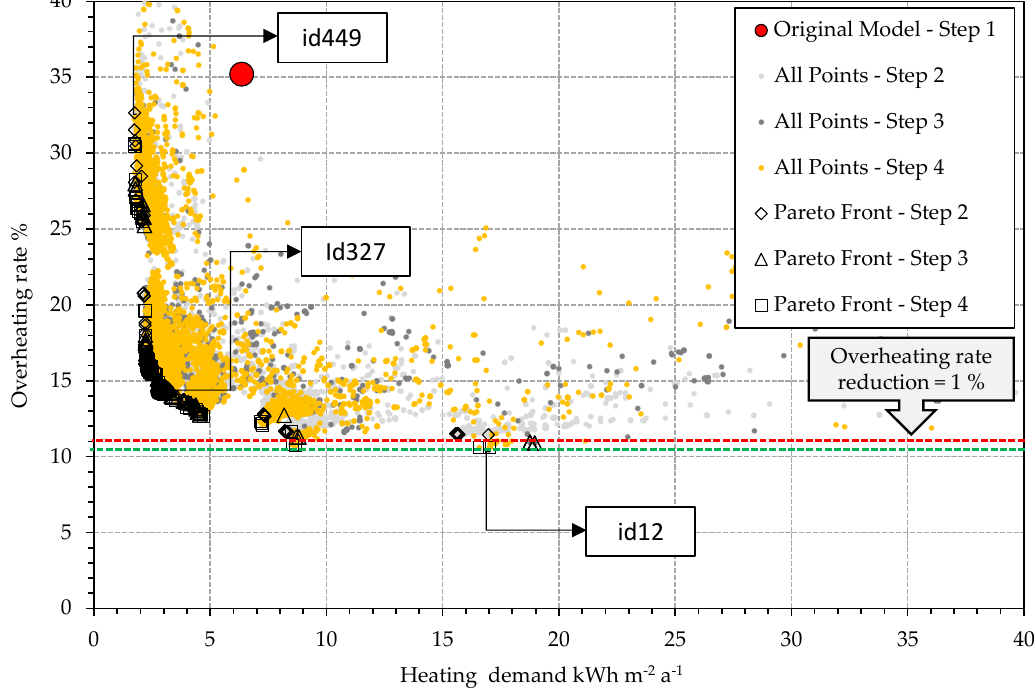
Figure 10. Pareto fronts and all simulated results: Step 4.